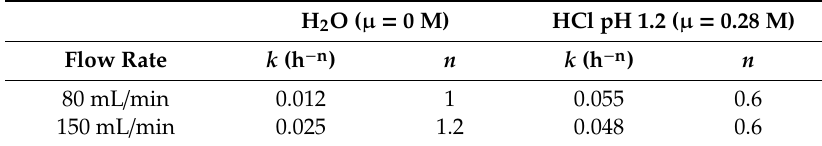
Figure 2. ( a ) 2D MR images of xanthan tablets during swelling at di ff erent flow rates in water and in the acid medium and ( b ) corresponding hydrogel layer thicknesses and fractions of the released pentoxifylline drug at di ff erent swelling times and mechanical stresses. Table 1. Values of the fitting parameters determined from drug release data measured at two di ff erent flow rates and fit by Equation (1) in water and in the acid